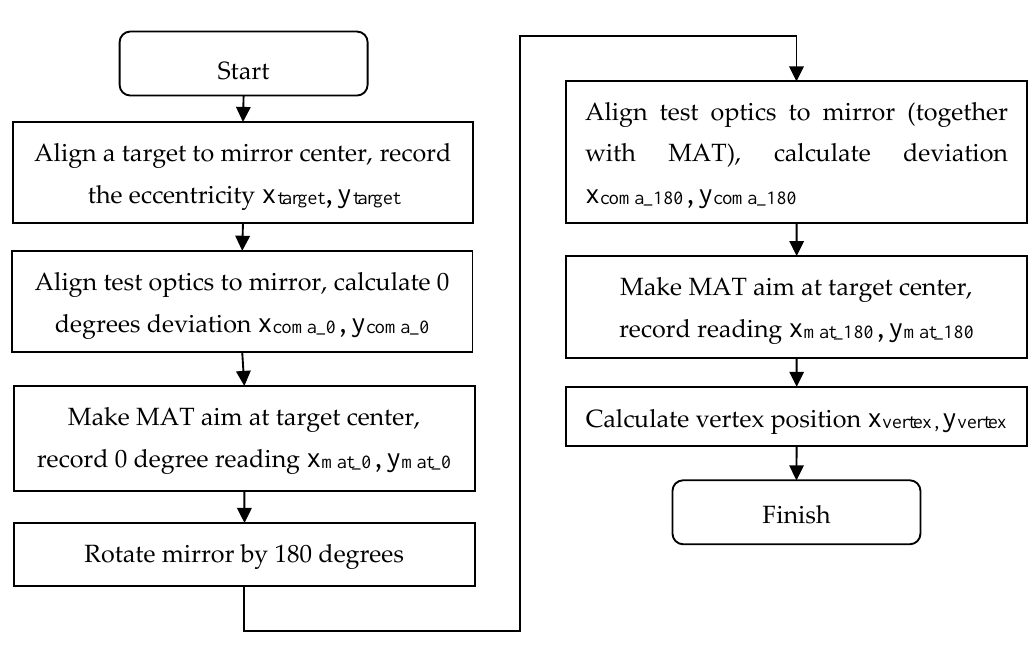
Figure 1. Vertex position measurement process.